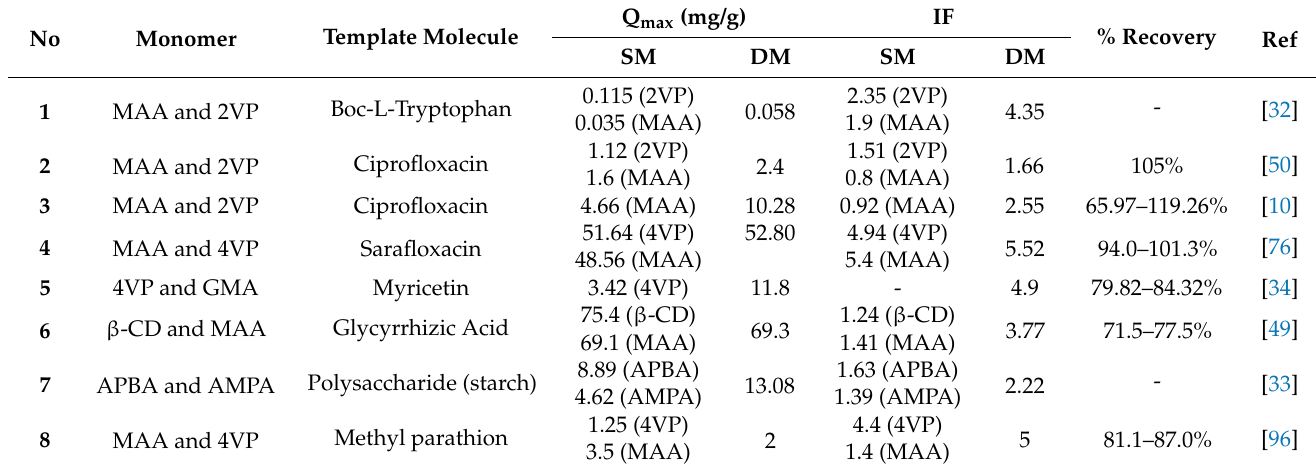
Table 1. Dual-Functional Monomer MIP Applications as an MI-SPE